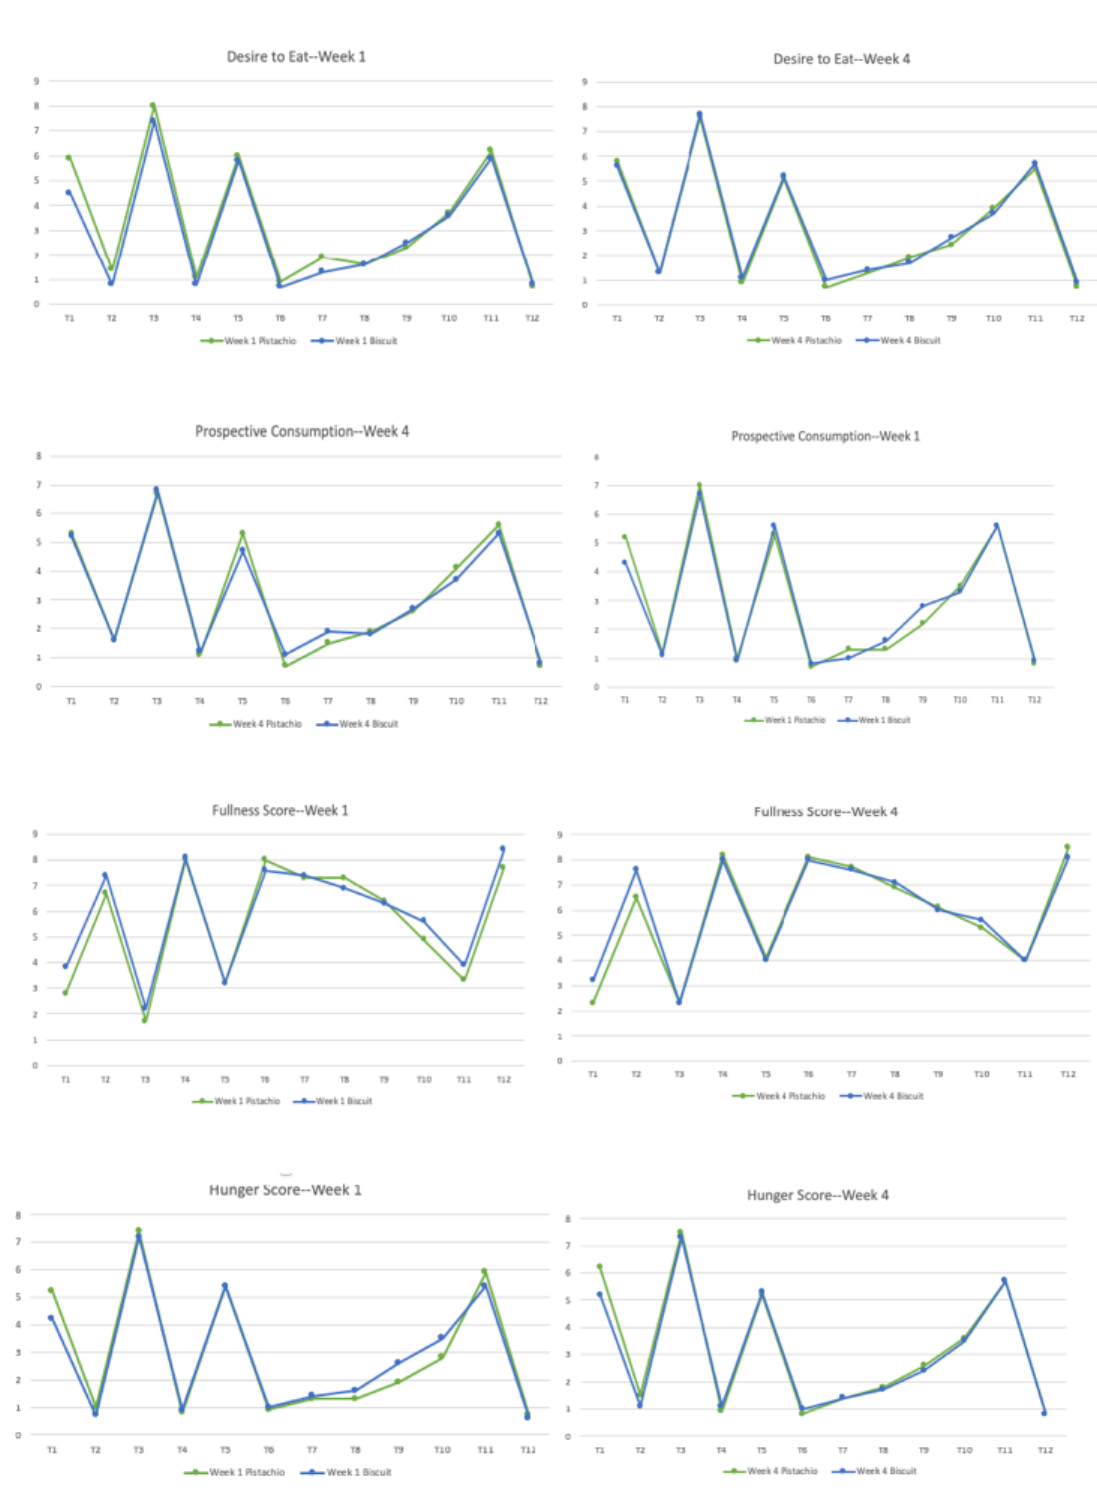
Figure 2. Mean visual analog scales (VAS) scores taken during the first week (week 1) and the last week (week 4) of the study. Time: Immediately before breakfast (T1) immediately after breakfast (T2), immediately before lunch (T3) immediately after lunch (T4), immediately before the goûter (T5) immediately after the goûter (T6), at 30 (T7), 60 (T8), 90 (T9), and 120 min after the goûter (T10), immediately before dinner (T11) and immediately after dinner (T12).